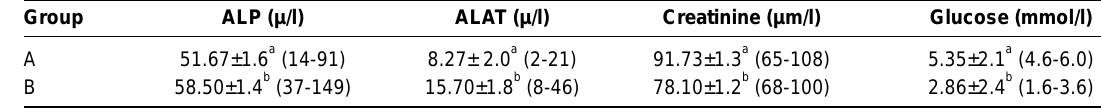
Table-3. Mean ± SD (range) of serum enzymes and metabolites of experimental dogs.